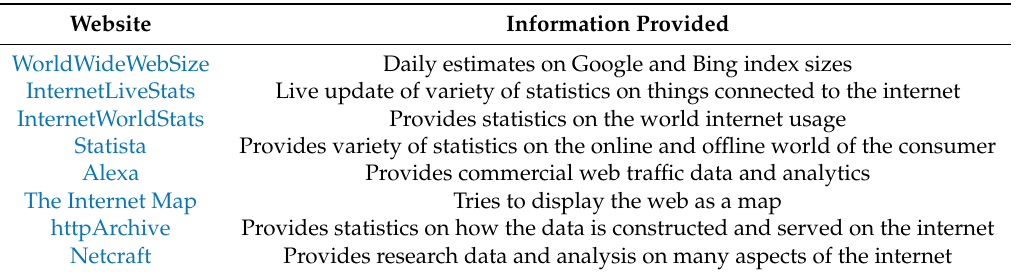
Table 1. Web-based platforms offering